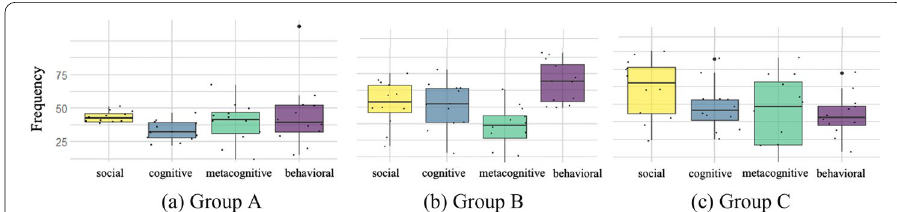
Fig. 3 Three groups’ distribution boxplots of social, cognitive, metacognitive and behavioral frequencies. Each box represents students’ code frequencies (minimum, median, and maximum values) throughout four weeks on one dimension